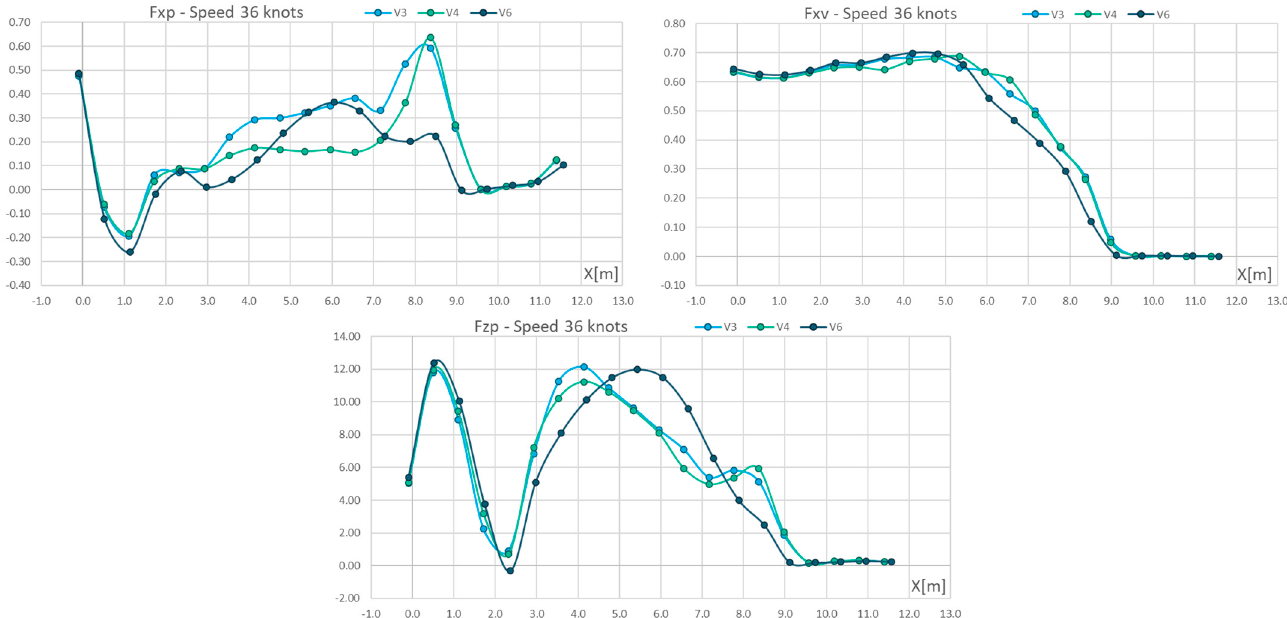
Figure 11. Comparison of Fxp, Fxv and Fzp along the hull for V3, V4 and V6.